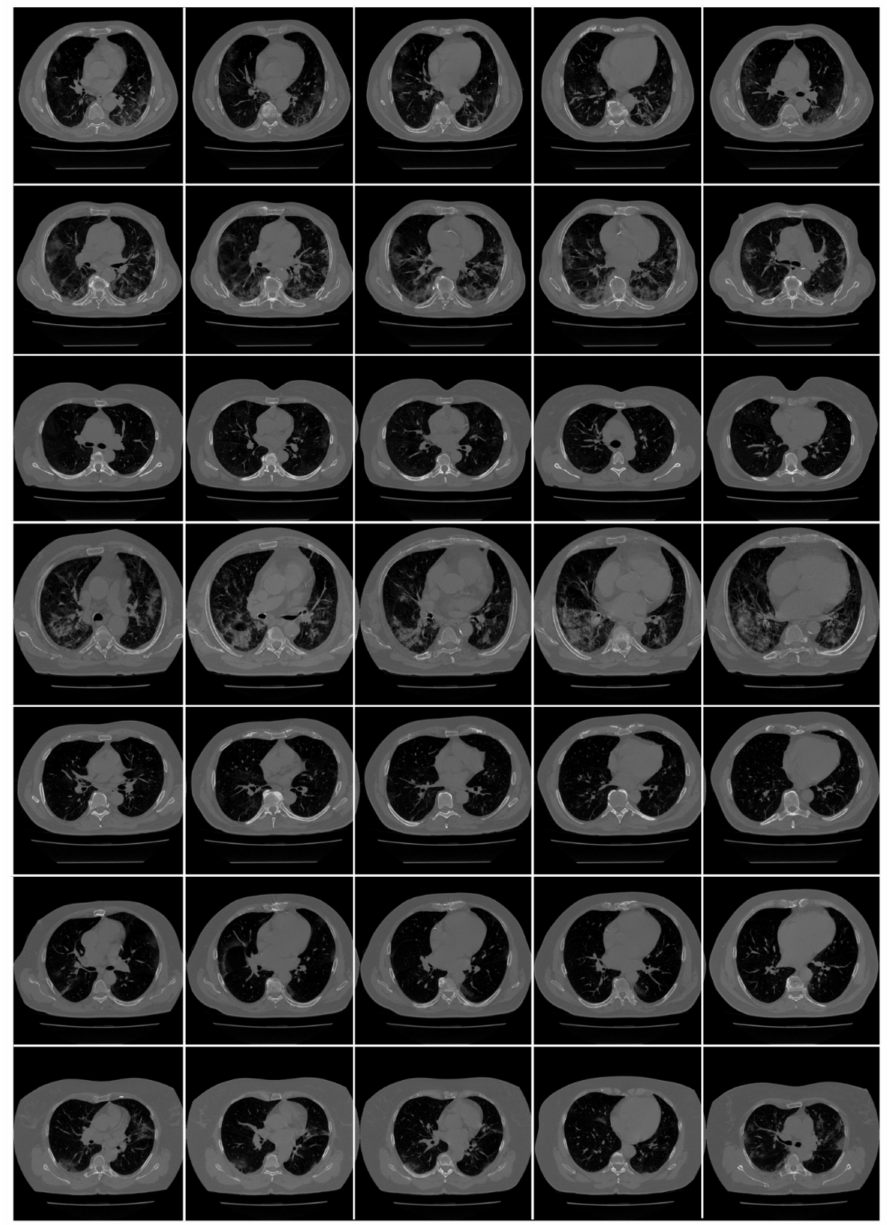
Figure 3. Raw CT images from the CROATIA